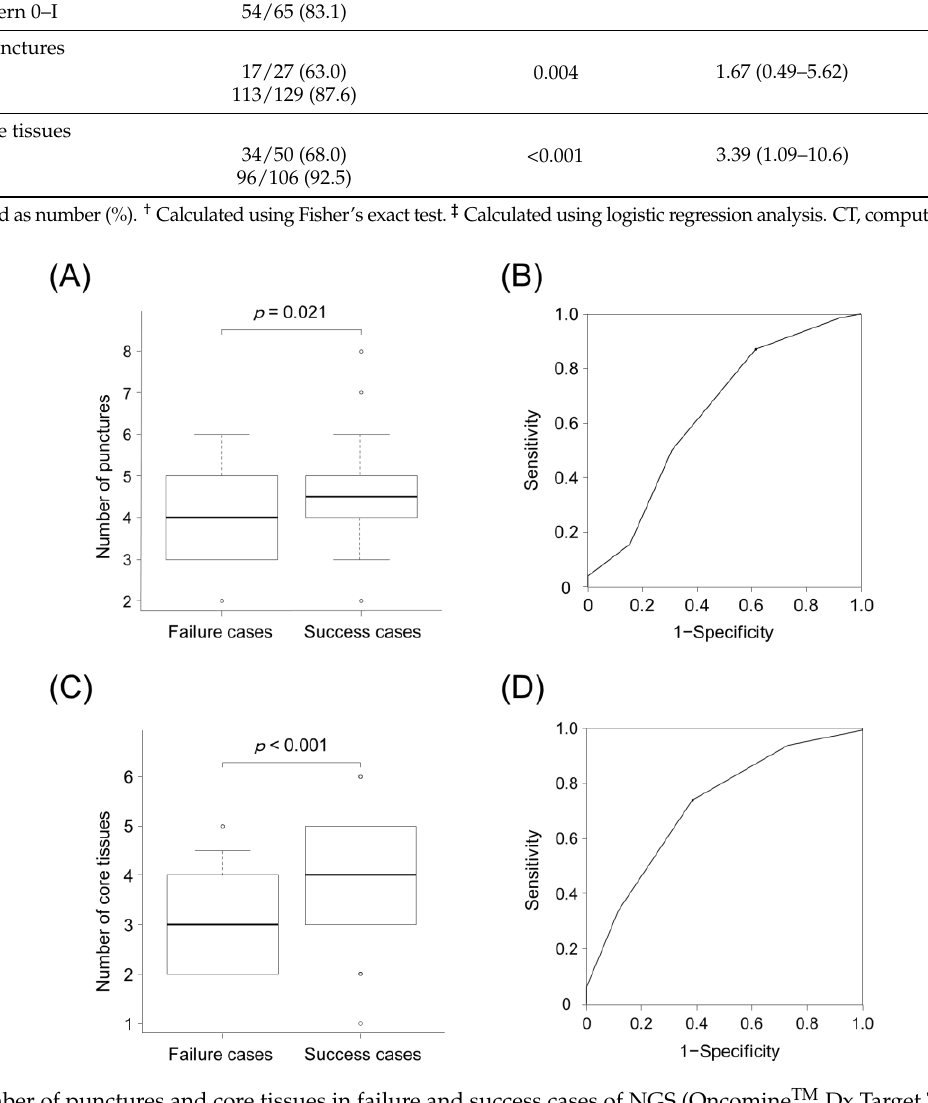
Figure 3. Number of punctures and core tissues in failure and success cases of NGS (Oncomine TM Dx Target Test) analysis using specimens obtained through EBUS-TBNA. ( A ) Success cases showed a higher number of punctures than failure cases (5 vs. 4, p = 0.021, Mann – Whitney U test). ( B ) ROC curve analysis yielded a cut-off value of 4 for the number of punctures. Using this cut-off value, the sensitivity and specificity of the number of punctures for predicting successful NGS were 38.5% and 86.9%, respectively. The area under the curve was 0.637 (95% confidence interval, 0.51 – 0.765). ( C ) Success cases showed a higher number of core tissues than failure cases (4 vs. 3, p < 0.001, Mann – Whitney U test). ( D ) ROC curve analysis yielded a cut-off value of four for the number of core tissues. With this cut-off value, the sensitivity and specificity of the number of core tissues for predicting successful NGS were 61.5% and 73.8%, respectively. The area under the curve was 0.718 (95% confidence interval, 0.613 – 0.823). In ( A ) and ( C ), the bottom and top of the boxes indicate the 25th and 75th percentiles, respectively. The middle line of the boxes indicates the median. The whiskers indicate the 10th and 90th percentiles, and cases lying beyond these range are marked as circle dots.